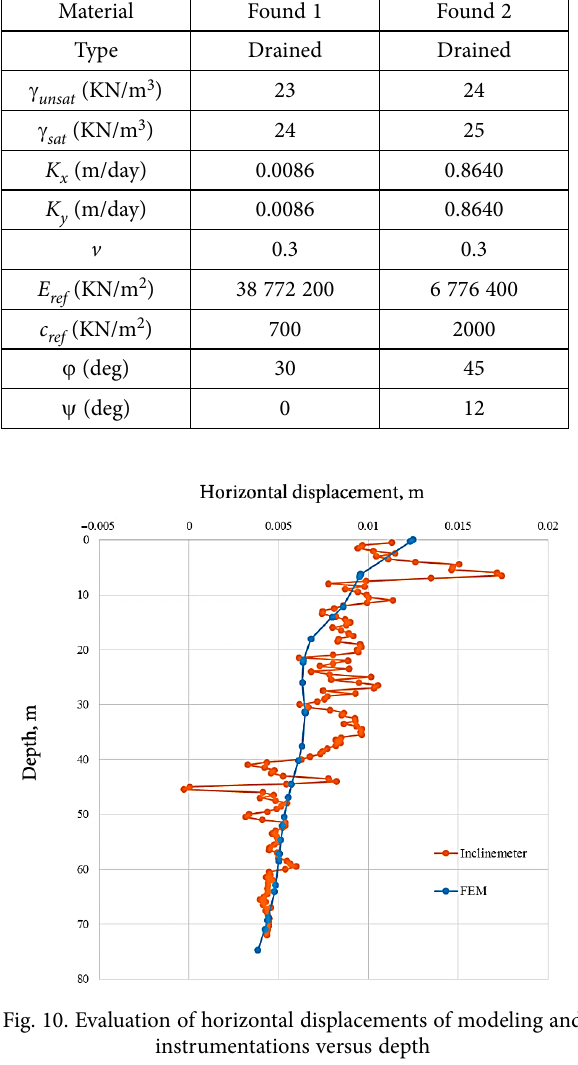
Table 2. Material property of dam foundation in Mohr-